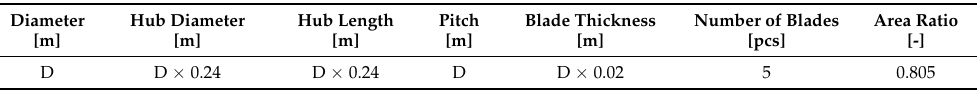
Table 1. The main parameters of the